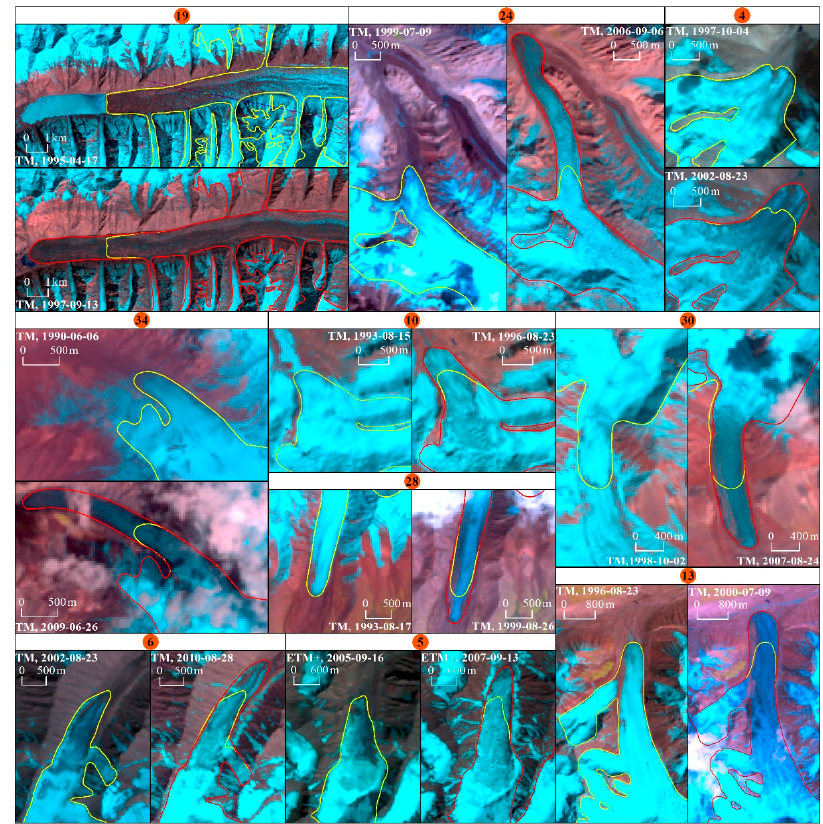
Figure 9. Surging glaciers in the Tien Shan Range. Figure shows glacial boundaries at the beginning and end of a surge using remote sensing images acquired at the end of the surging glacier (refer to Table 1 for glacier numbers): glaciers 19, 24, 4, 34, 10, 30, 28, 13, 6, and 5 acquired using Landsat Thematic Mapper (TM) and Enhanced Thematic Mapper (ETM+) imagery.